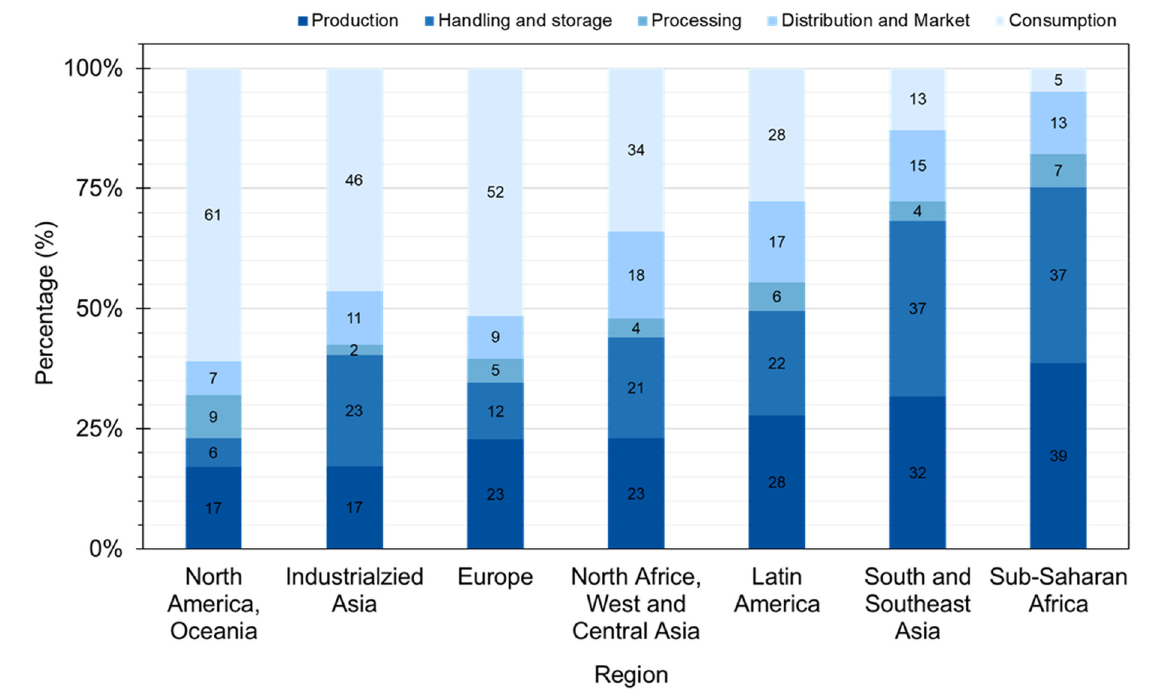
Figure 2. The percentage of food loss or waste by region and stage in the food value chain in 2009 [Source WRI analysis based on FAO. 2011 [41].